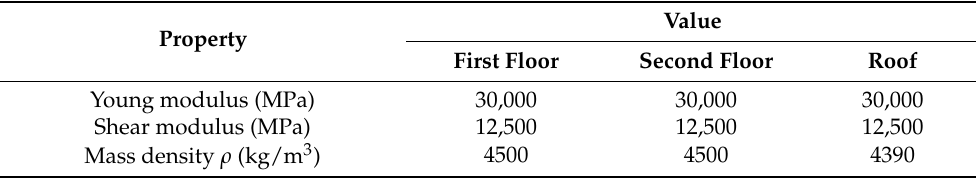
Table 10. Properties of the shell elements (thickness = 68 mm) representing the concrete slabs in configuration